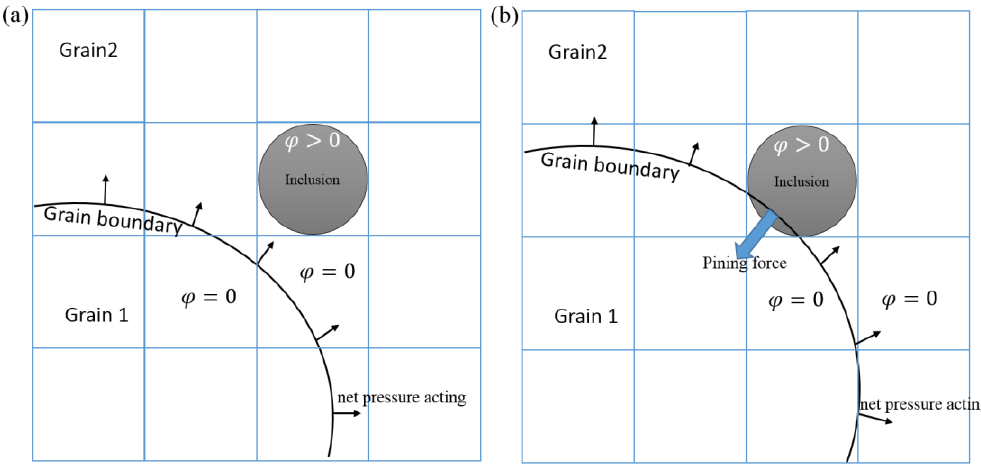
Figure 1. The pinning effect act on the grain boundaries ( a ) before the grain boundaries reach the inclusion, ( b ) after the grain boundaries meet the inclusion.